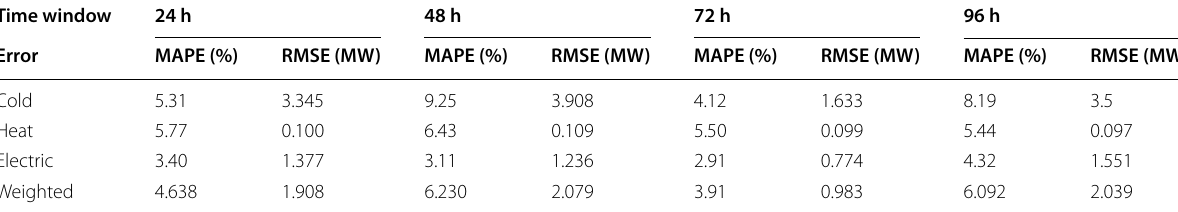
Table 7 The prediction errors by setting different time window Time